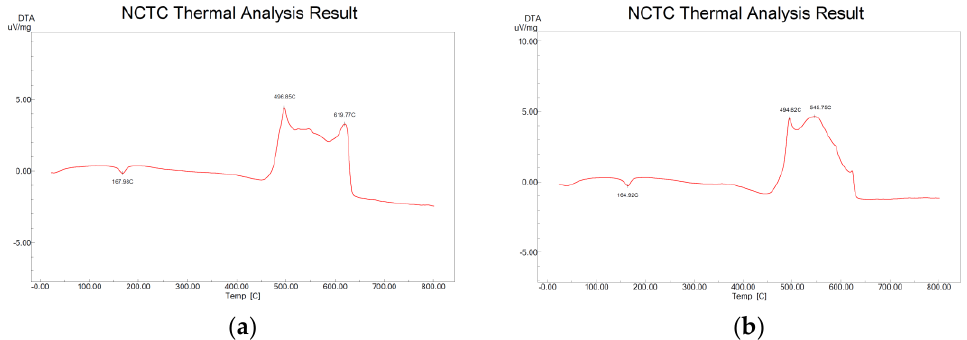
Figure A2. DTA analysis of ( a ) virgin MF and ( b ) virgin UF membranes at the nitrogen gas flow rate of 50 mL/min.